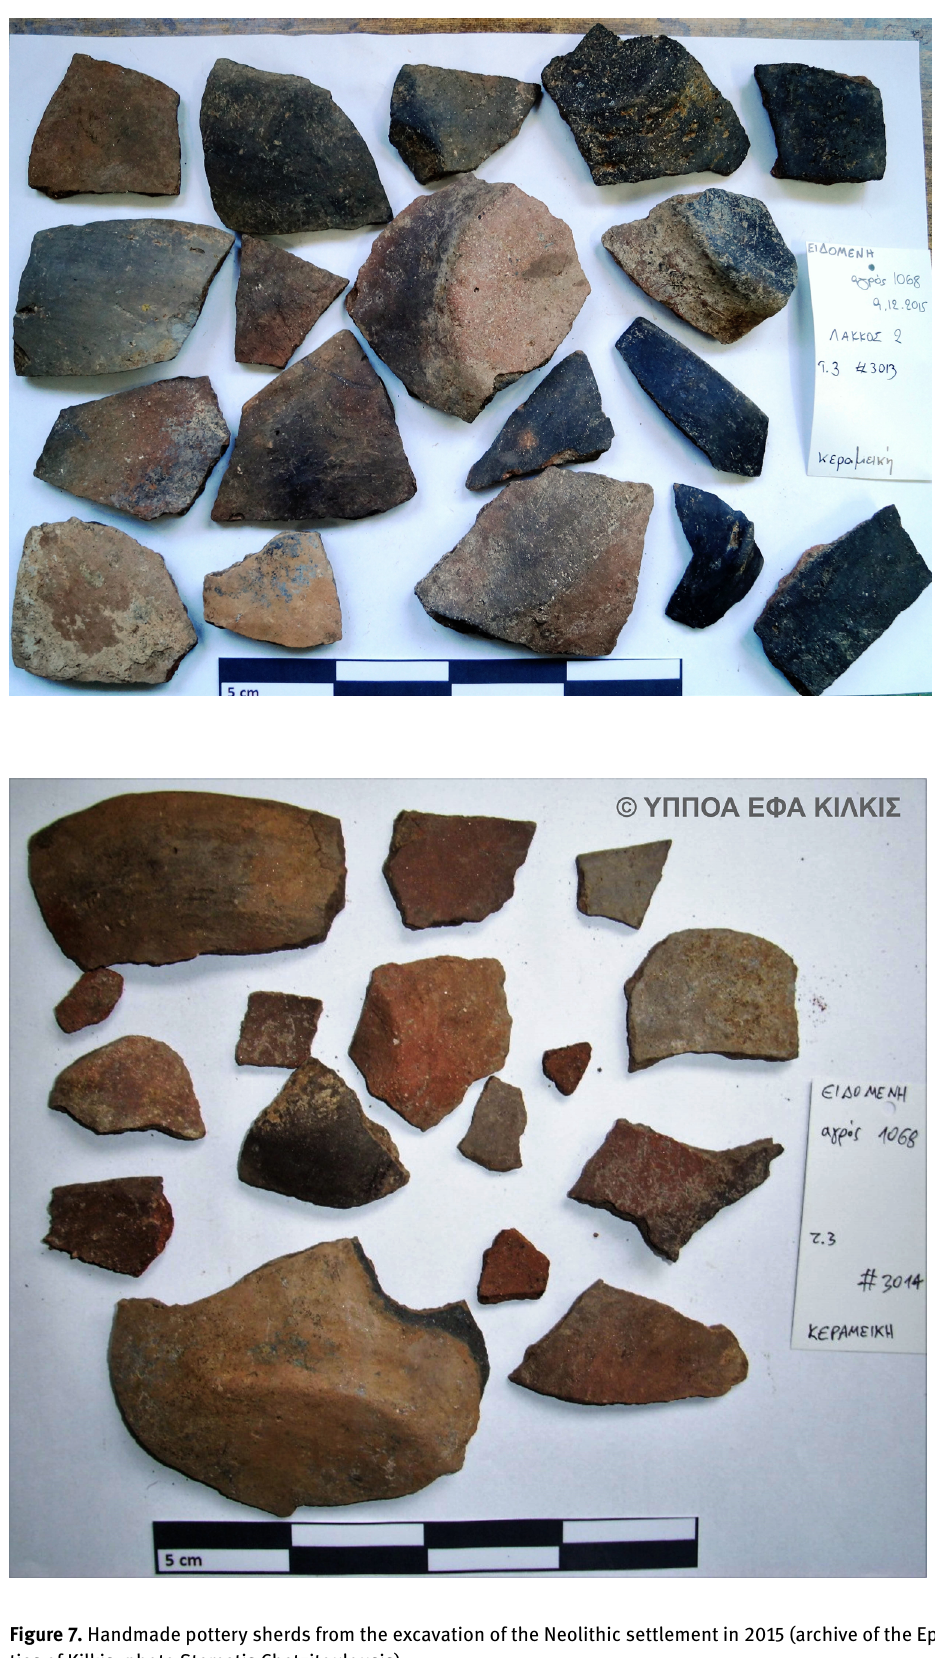
Figure 7. Handmade pottery sherds from the excavation of the Neolithic settlement in 2015 (archive of the Ephorate of Antiqui- ties of Kilkis, photo Stamatis